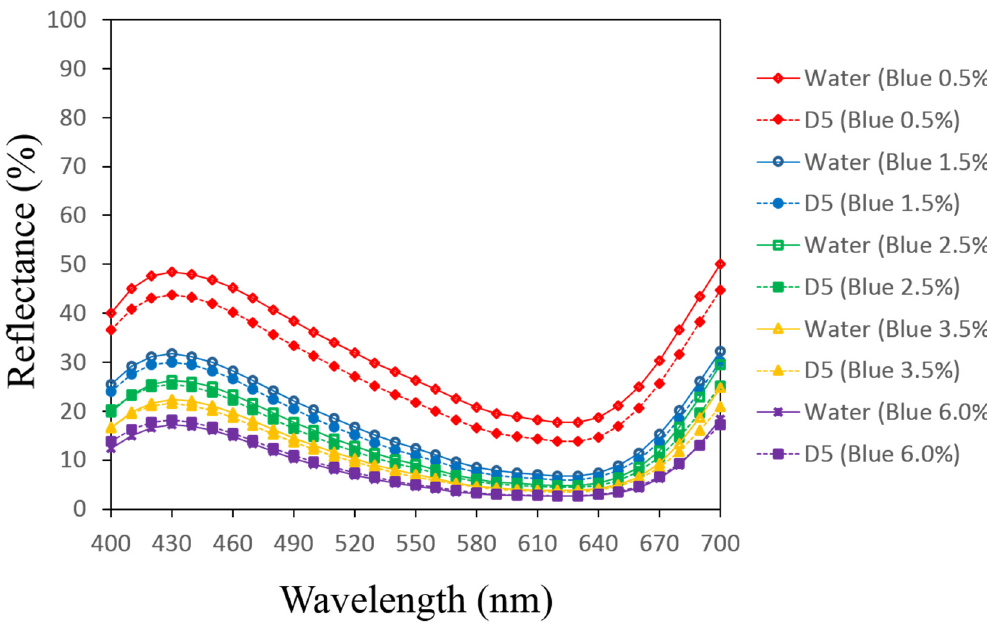
Figure 5. Reflectance curves of the blue color of batch samples dyed in water and D5 medium.